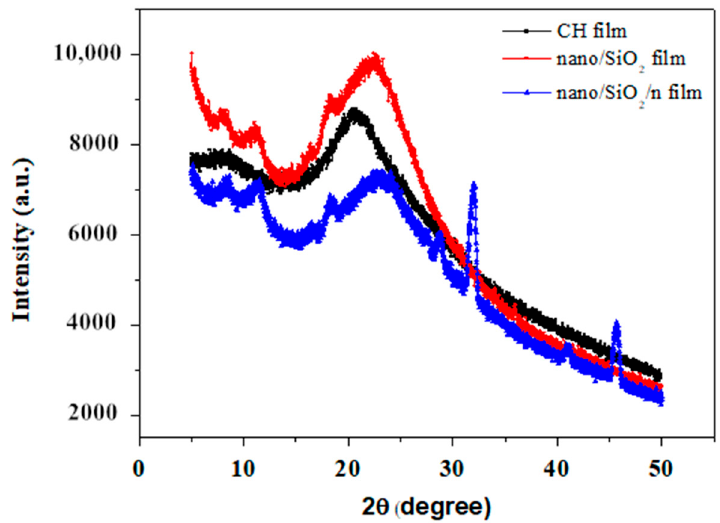
Figure 6. XRD patterns of novel thin